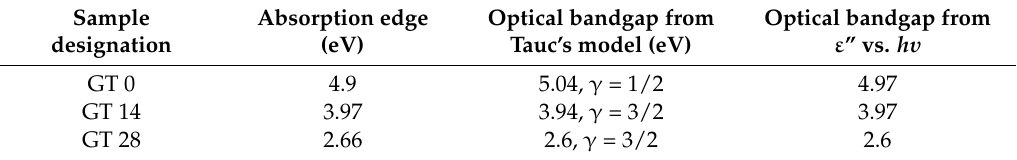
Figure 7. The absorption coefficients versus photon energy for pure PMMA and PMMA doped samples. Table 1. The absorption edge, optical band gap (from Tauc’s model and ε″ vs. h υ ) for all the samples.